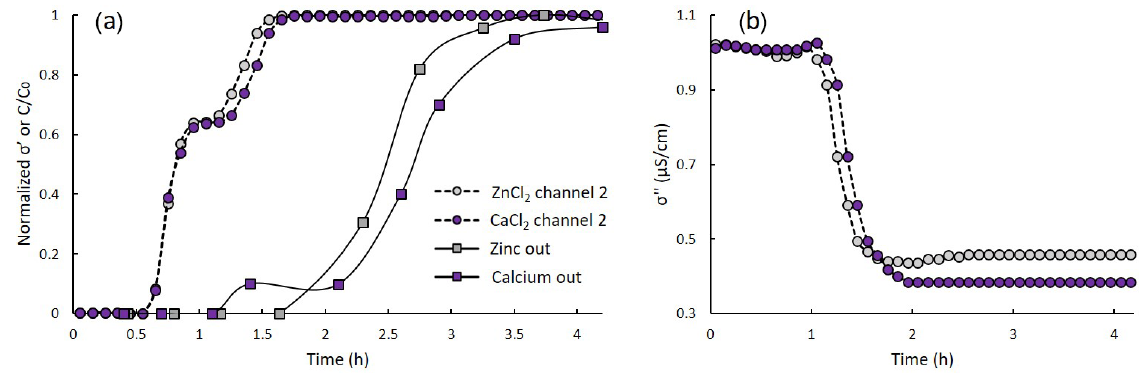
Figure 6. Normalized real conductivity (a) and imaginary conductivity (b) vs. time at 1Hz vs. (channel 2) for CaCl 2 and ZnCl 2 transport in a homogeneous sandy profile. The rectangular markers symbolize the measured outflow Zn 2 + and Ca 2 + concentrations.